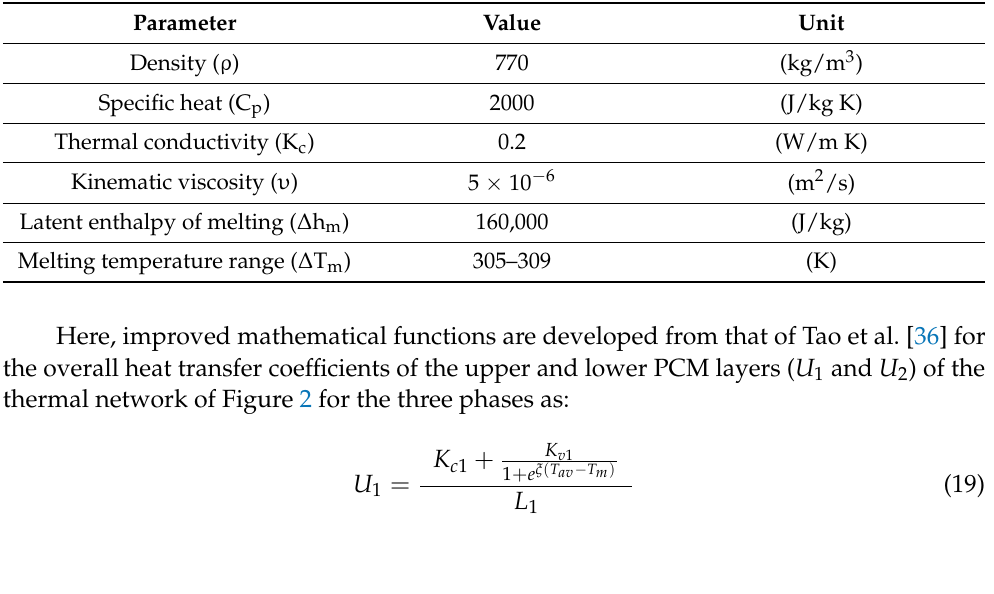
Table 1. Thermo-physical parameters of the considered PCM (RT-35)